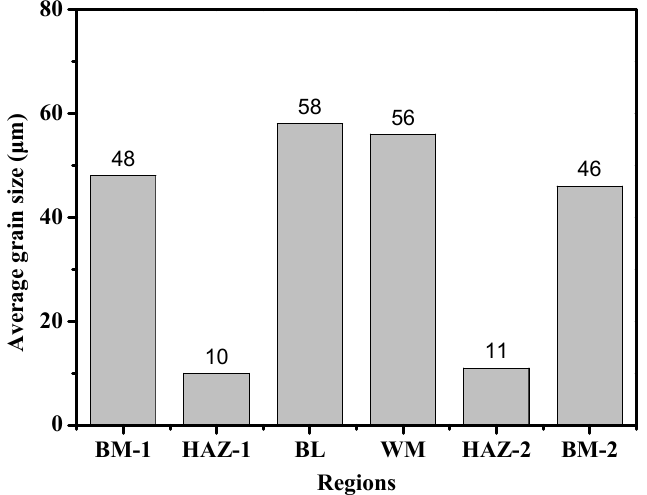
Figure 13. Average grain size in different regions of the DMWJ.